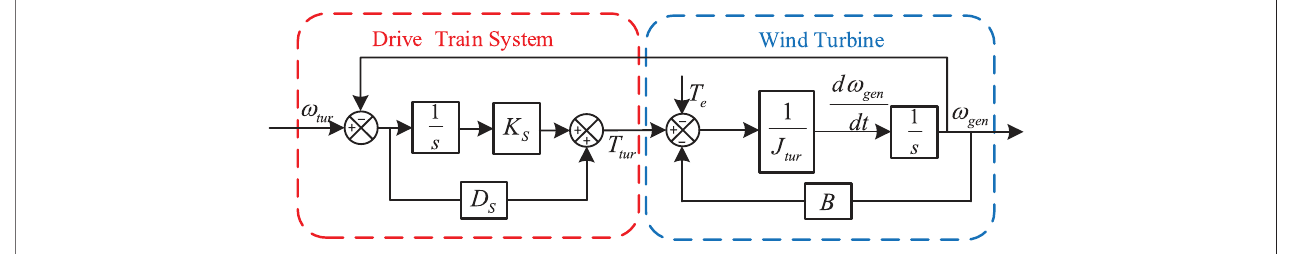
FIGURE 5 | Block diagram of the transmission system.